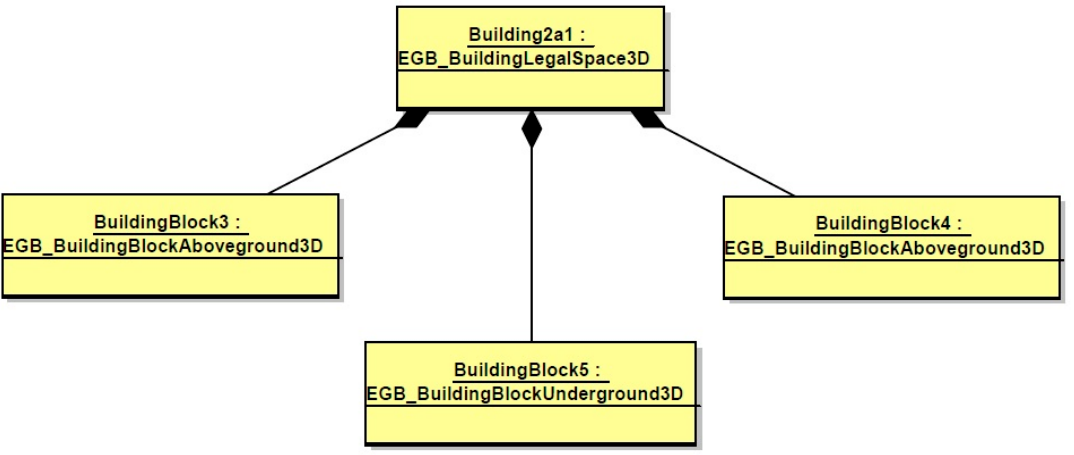
Figure 14. The UML schema of instance where the underground part is a separate object within one property.